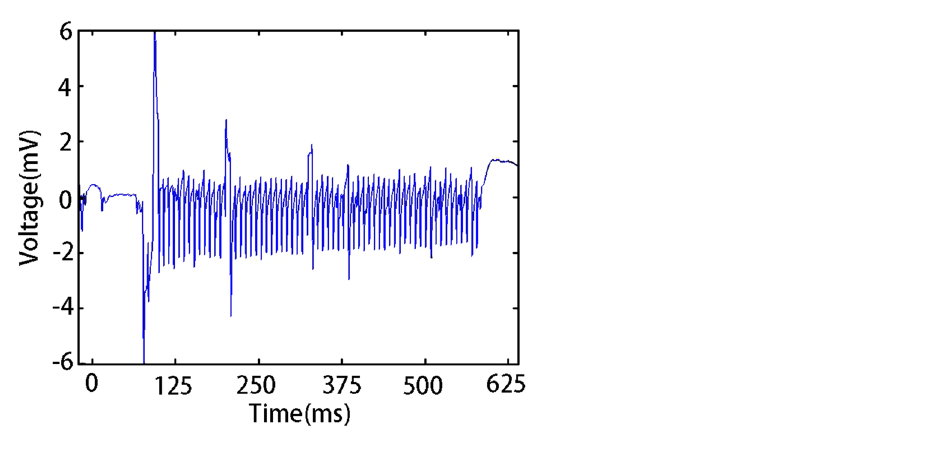
Figure 7. Response of the rat under electrical stimulation. Response ECoG signal of a rate when electrical stimulation is applied, which achieves an epilepsy condition, demonstrating the ability of the ECoG device for recording of brain wave signals and for providing electrical stimulation